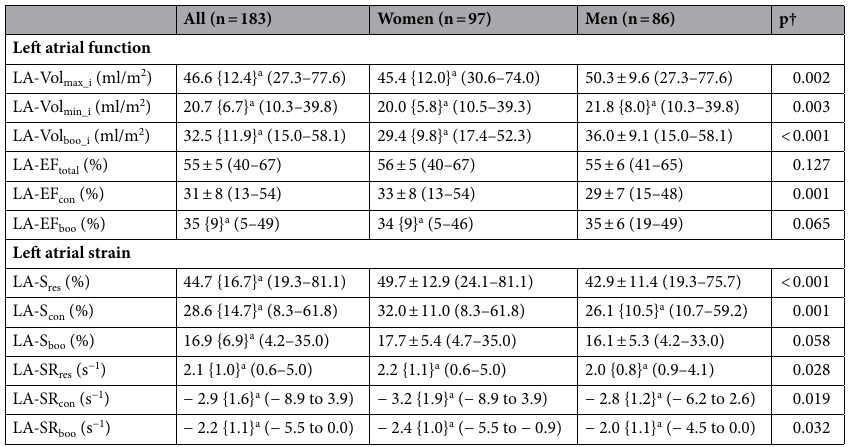
Table 2. Left atrial strain and volumes of the total cohort. Normally distributed values were expressed as mean ± standard deviation, otherwise as median ( a ) with interquartile range. Ranges in parentheses. † p-value related to gender. Normally distributed data were tested by the unpaired t-test, otherwise with the Mann– Whitney-U-test. LA-Vol max_i indexed maximum left atrial volume, LA-Vol min_i indexed minimum left atrial volume, LA-Vol boo_i indexed booster left atrial volume, LA-EF total total left atrial ejection fraction, LA-EF con passive left atrial ejection fraction, LA-EF boo booster left atrial ejection fraction, LA-S res reservoir left atrial strain, LA-S con conduit left atrial strain, LA-S boo booster left atrial strain, LA-SR res reservoir left atrial strain rate, LA-SR con conduit left atrial strain rate, LA-SR boo booster left atrial strain rate.